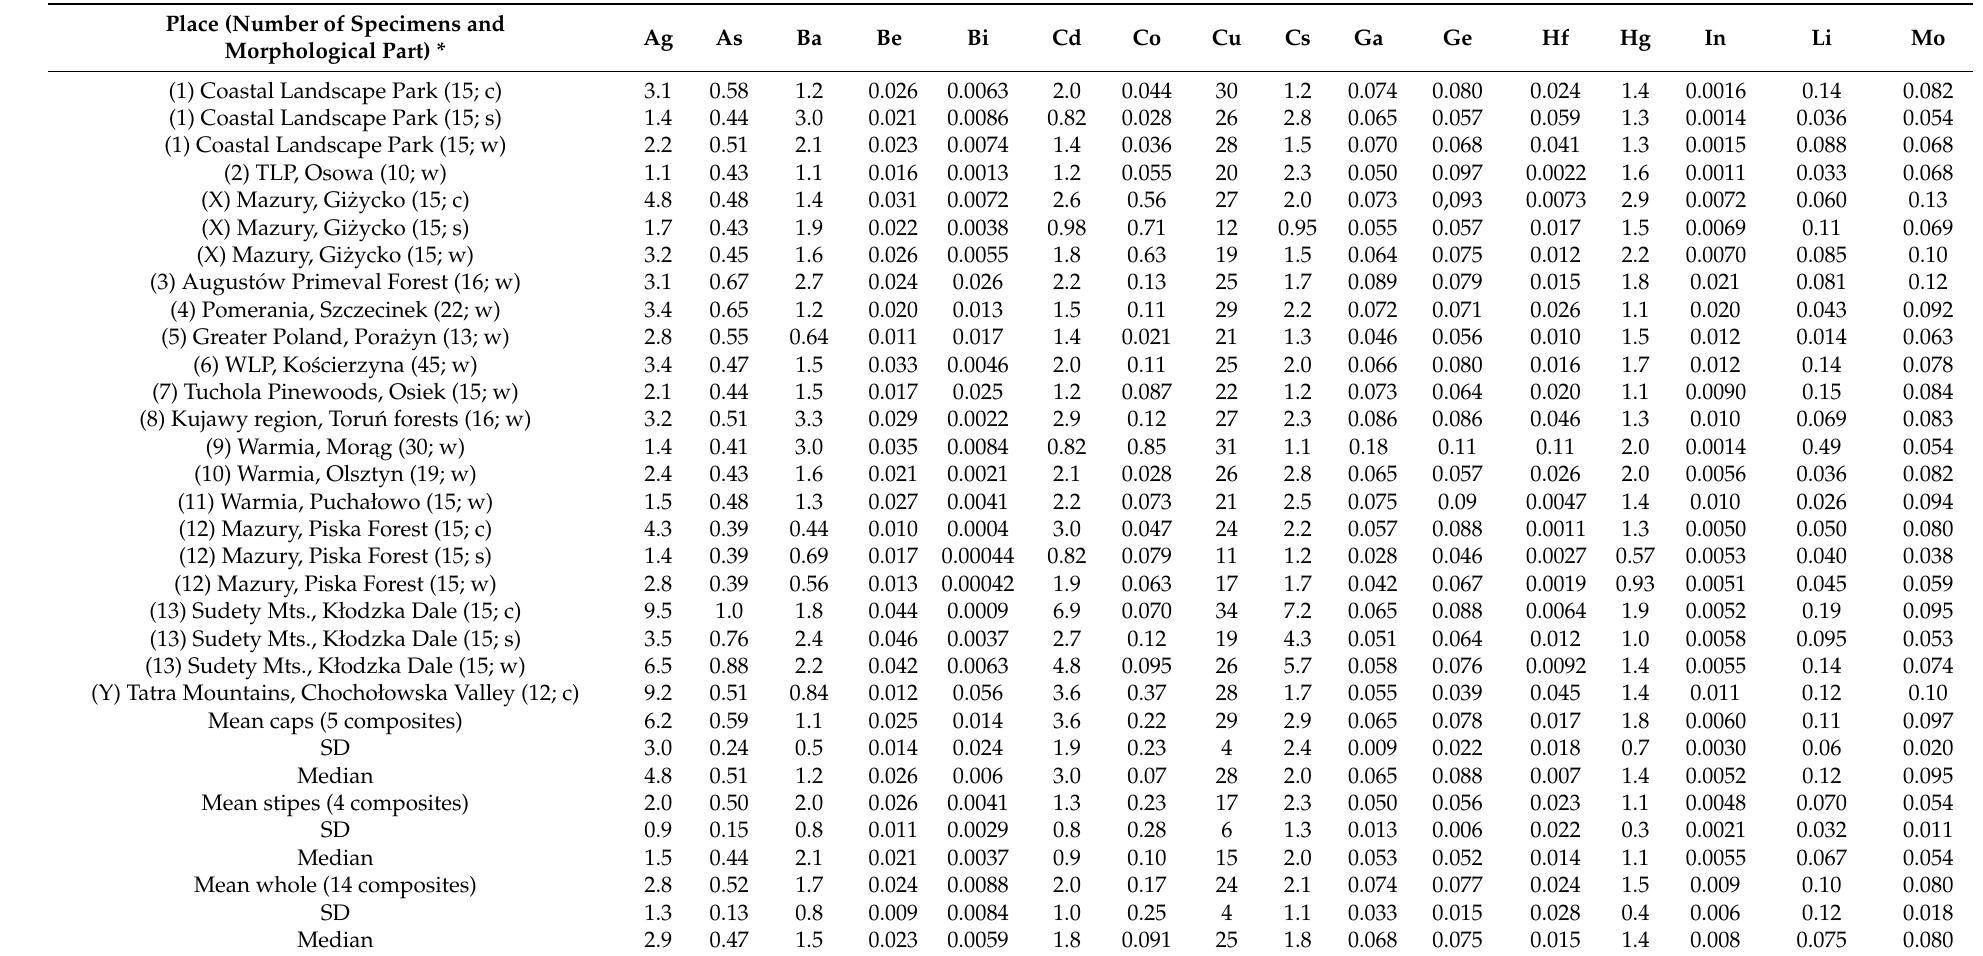
Table 1. Elements in fruiting bodies of B. edulis (mg kg − 1